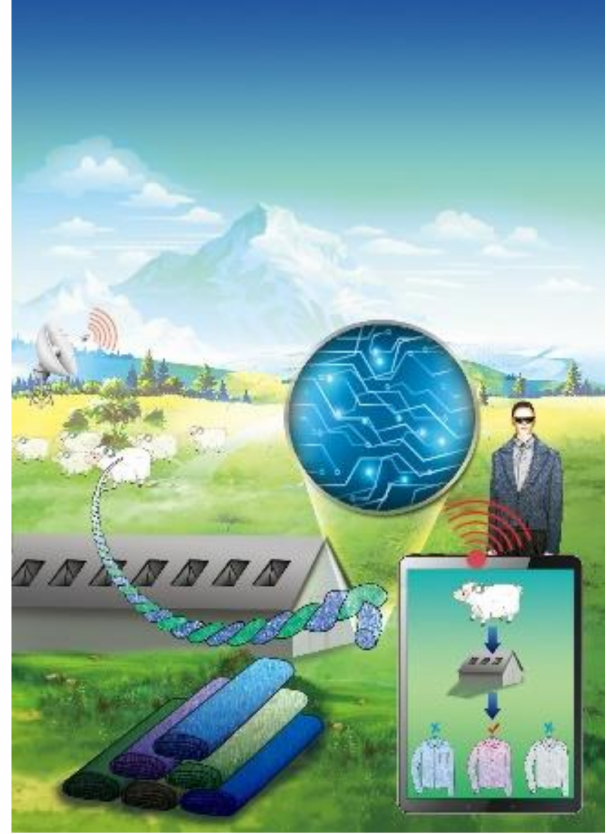
Figure 1. Schematic of proposed wearable sensors for authenticating provenance using radio frequency